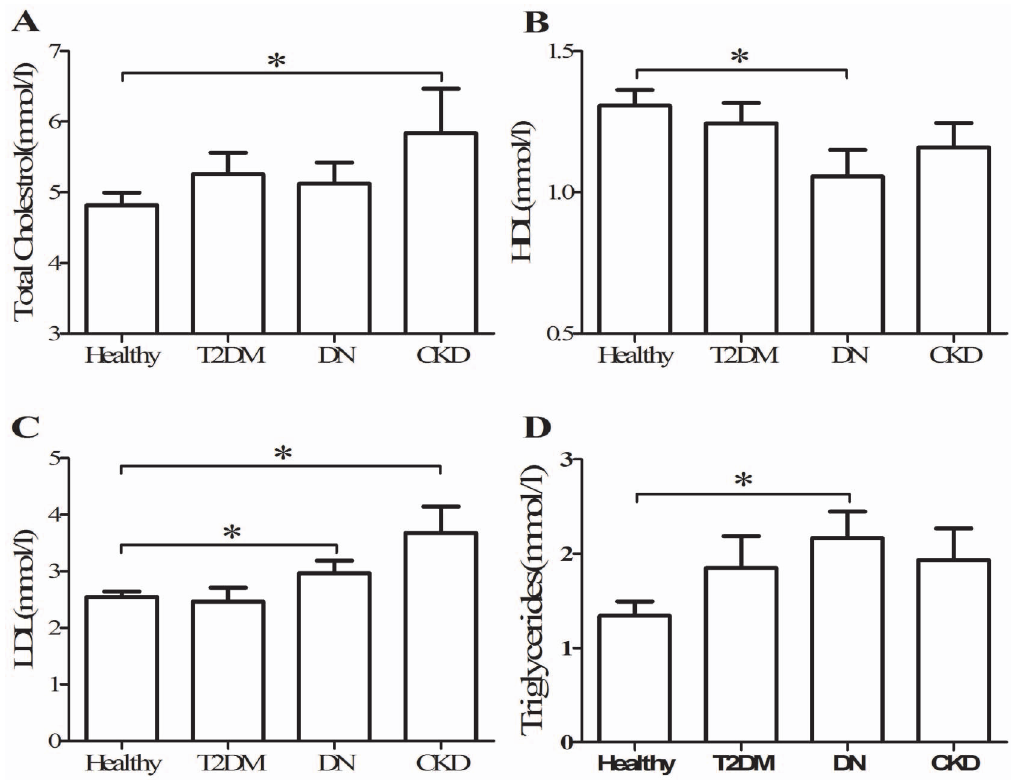
Figure 1. Serum concentration of total cholesterol(A), HDL (B), LDL (C), and triglycerides (D) among T2DM, DN, CKD, and healthy subjects. *, p , 0.05.